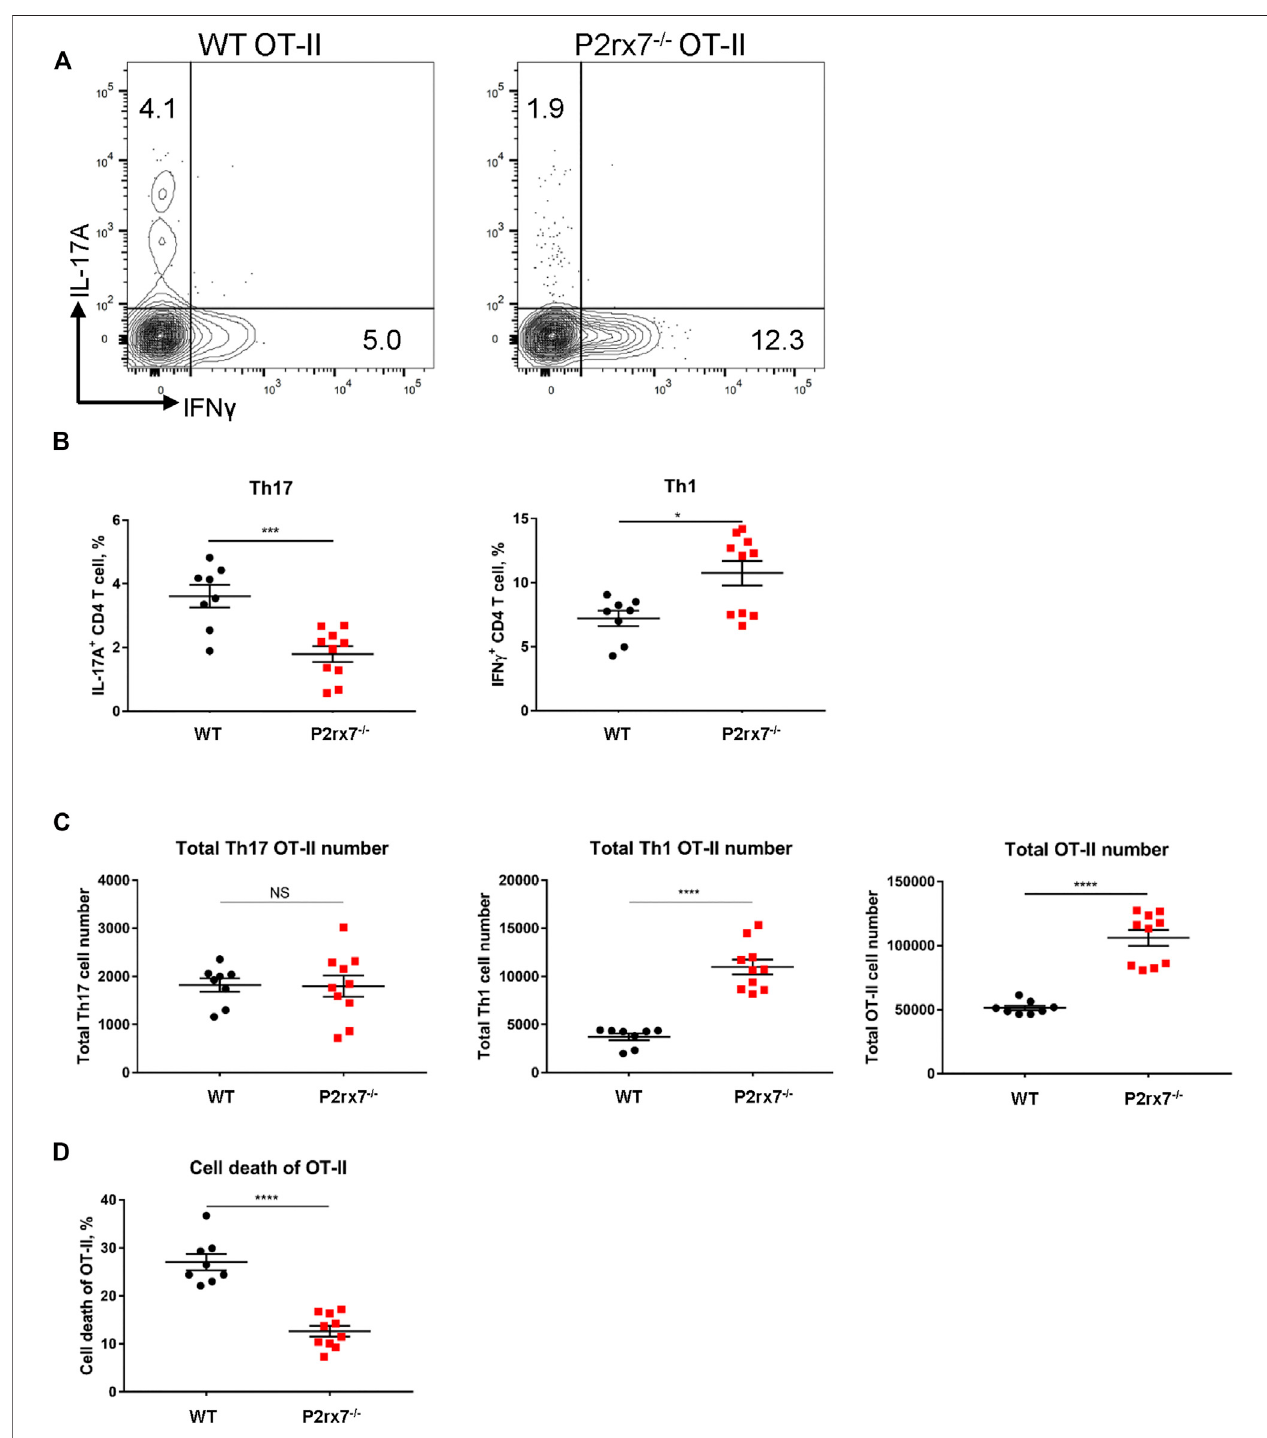
FIGURE 5 | In vivo P2X7R expression on CD4 + T cells is not essential for Th17 differentiation. (A – D) Naive WT or P2rx7 − / − OT-II CD4 + T cells (both CD45.2) were adoptively transferred intravenously into congenic WT CD45.1 mice. The following day mice were immunized with OVA 323-339 /CFA. Inguinal LNs were collected and restimulated 7 days post-immunization. (A) Representative fl ow cytometric contour plots, cells were gated on CD3 + CD4 + CD45.2 + OT-II cells. (B,C) The percentage and total cell number of IL-17A + and IFN γ + OT-II T cells in the CD45.2 gate, were quantitated. (D) Cell death quanti fi ed by viability staining dye. Results shown as mean±SEM,eachdotrepresentsanindividualmouse.Onerepresentativeofthreeindependentexperiments.* p < 0.05,*** p < 0.001,**** p < 0.0001;NS,notsigni fi cant.